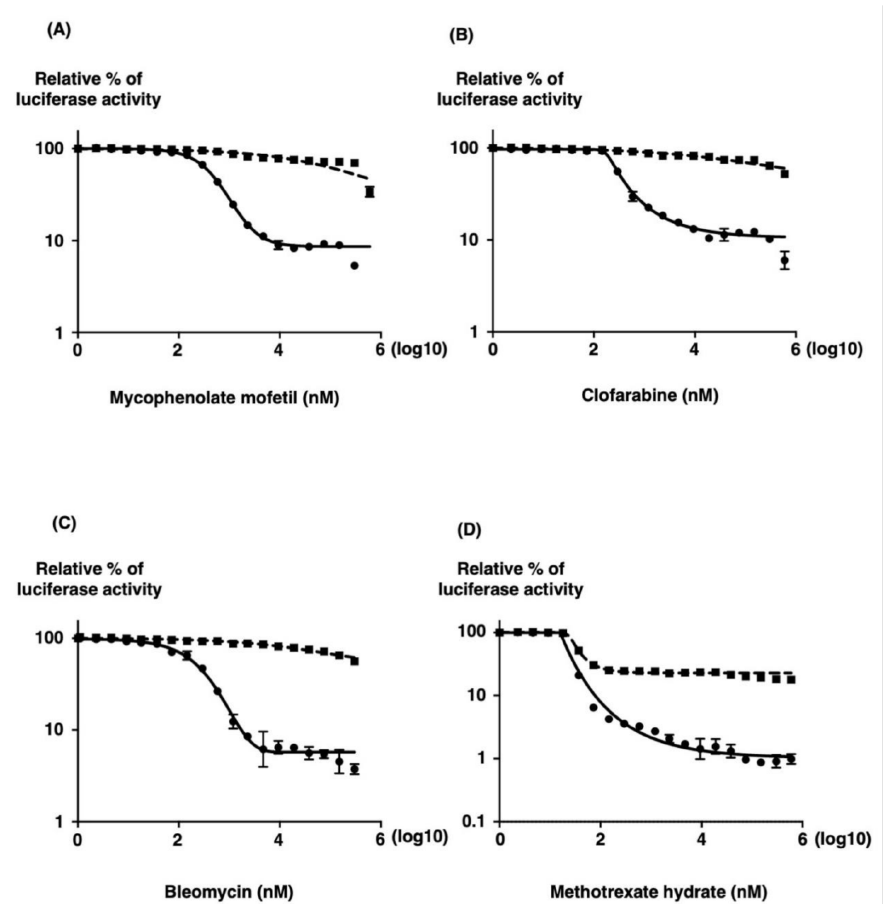
Figure 5. Inhibitory effect of mycophenolate mofetil, clofarabine, bleomycin, and methotrexate hydrate on SFTSV MG activity ( • ) in 293T cells. ( A ) One hour after transfection with MG, pKS-SFTSV-NP, and pKS-SFTSV-L plasmids, 293T cells were seeded in a 96-well plate in media containing various concentrations of mycophenolate mofetil ( A ), clofarabine ( B ), bleomycin ( C ), and methotrexate hydrate (MTX) ( D ). After 32 h of incubation, luciferase activities were measured. Cell viability ( (cid:4) ) was determined in the presence of drugs using the RealTime Glo MT Cell Viability Assay (Promega, Madison, WI) in parallel. The minigenome activity is expressed as the fold induction of normalized luciferase units relative to the background control (absence of reagents), corrected as a percentage of the activity observed in the presence of NP and L proteins for each MG. A sigmoidal dose–response curve was fitted to the data using GraphPad Prism 7. The results shown are for three independent assays, with error bars representing standard